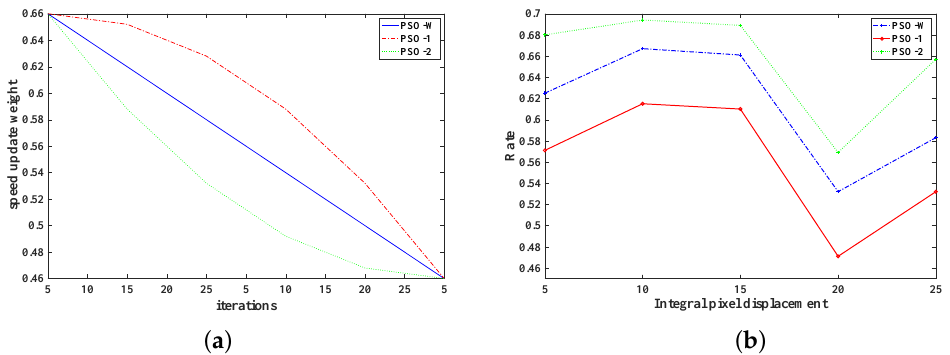
Figure 4. Three algorithms comparison of inertia weight factors with the number of iterations ( a ) and search efficiency ( b